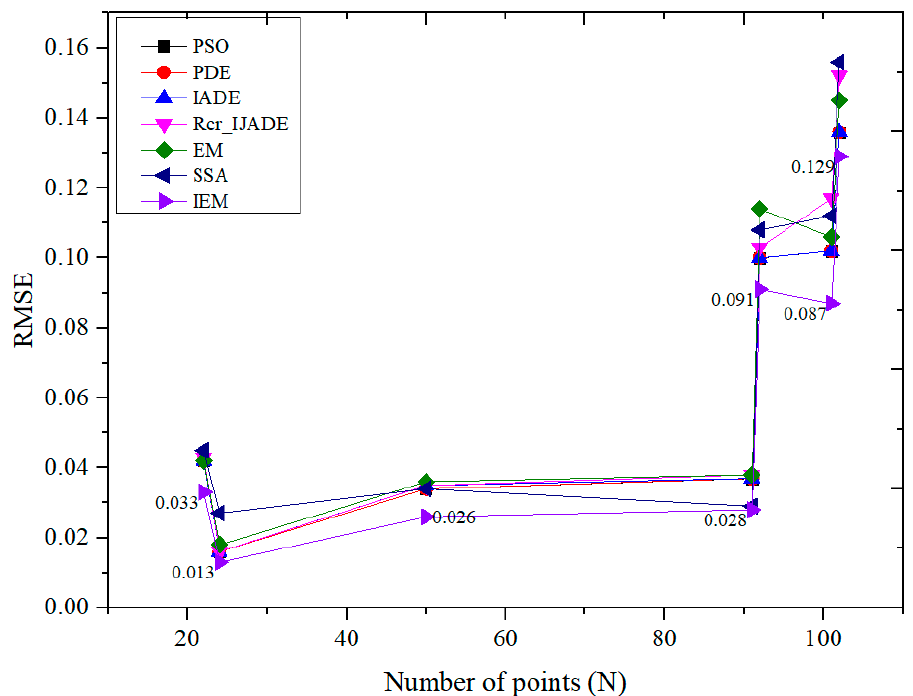
Figure 8. Root mean square error (RMSE) values of IEM, slap swarm optimization (SSA), EM, Rcr-IJADE, adaptive di ff erential evolution (IADE), and penalty-based di ff erential evolution (PDE) algorithms at various weather